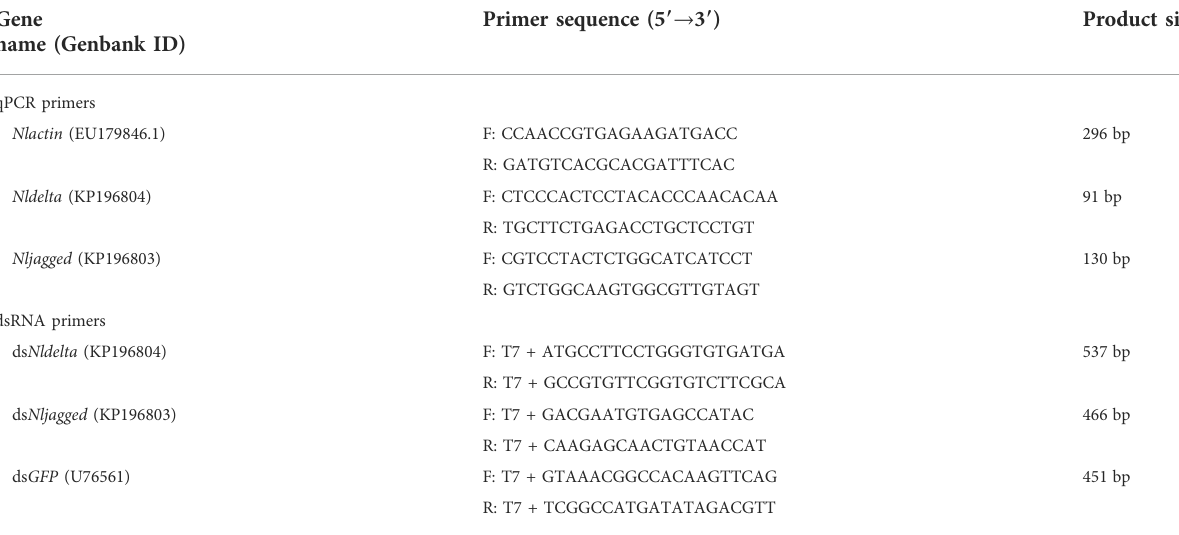
TABLE 1 Primers used in the current study.